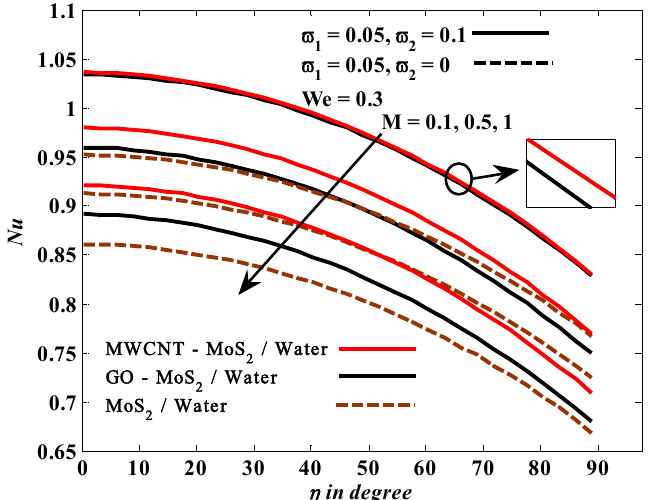
Figure 6. The behavior of hybrid nanofluid’s Nusselt number under the effect of M.